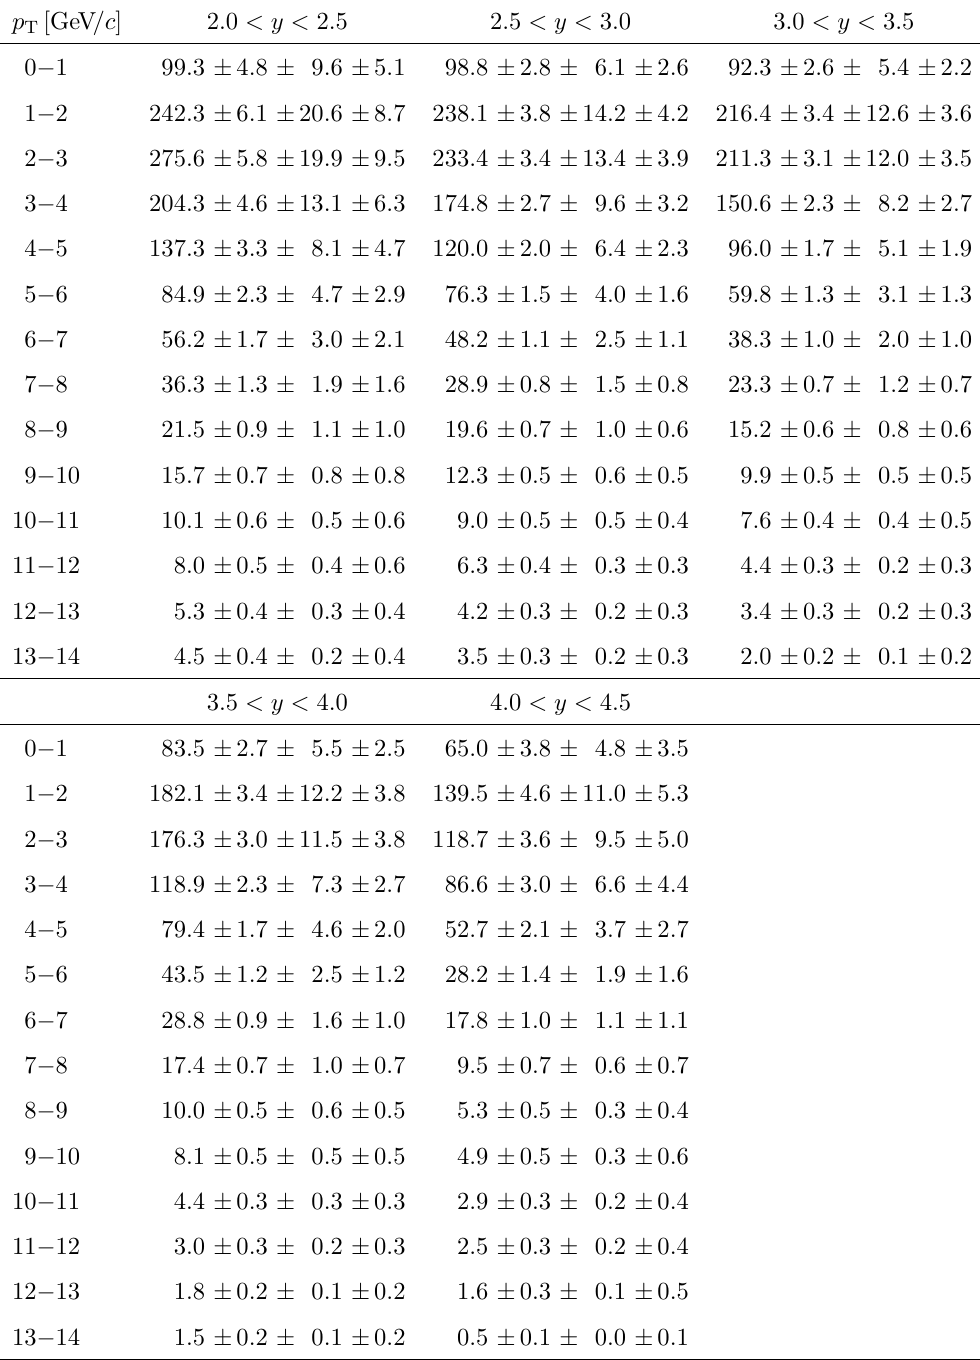
Table 3 . Double di(cid:11)erential production cross-section in nb = (GeV =c ) for J= -from- b mesons in bins of ( p T ; y ). The (cid:12)rst uncertainties are statistical, the second are the correlated systematic uncertainties shared between bins and the last are the uncorrelated systematic